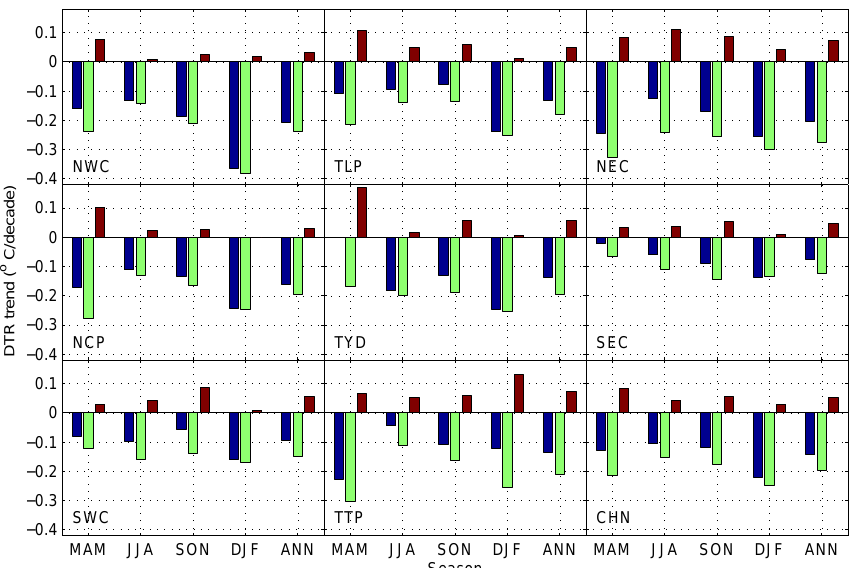
Fig. 6. Long-term trends of diurnal temperature range (blue) and contributions by changes in diurnal temperature range (green) and cloud cover (purple).